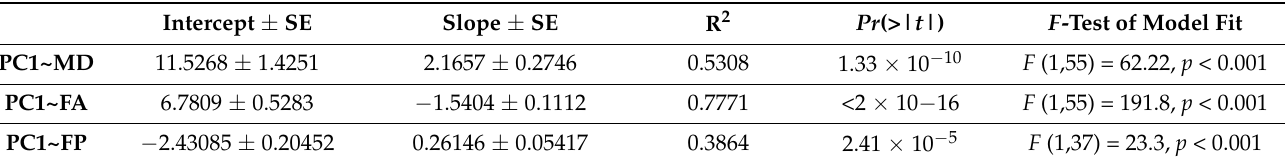
Figure 5. Detected breakpoints using multiple approaches of the sequential t -test and F -test. Table 2. Linear regression models containing no breakpoints between the stressors and ecological response.